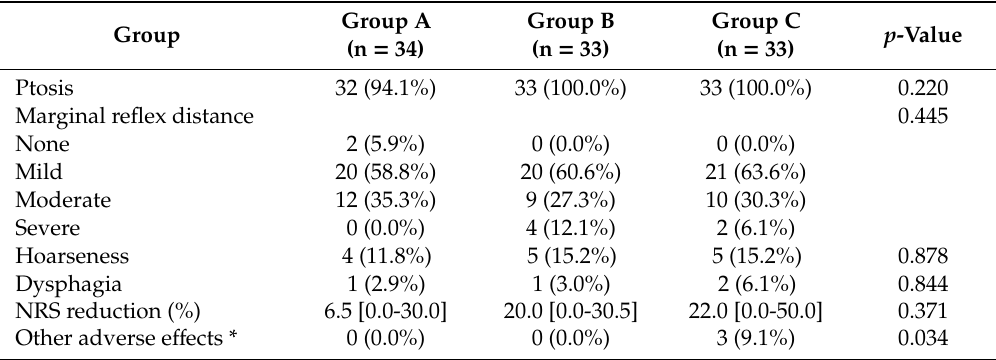
Table 4. Other block-related outcome